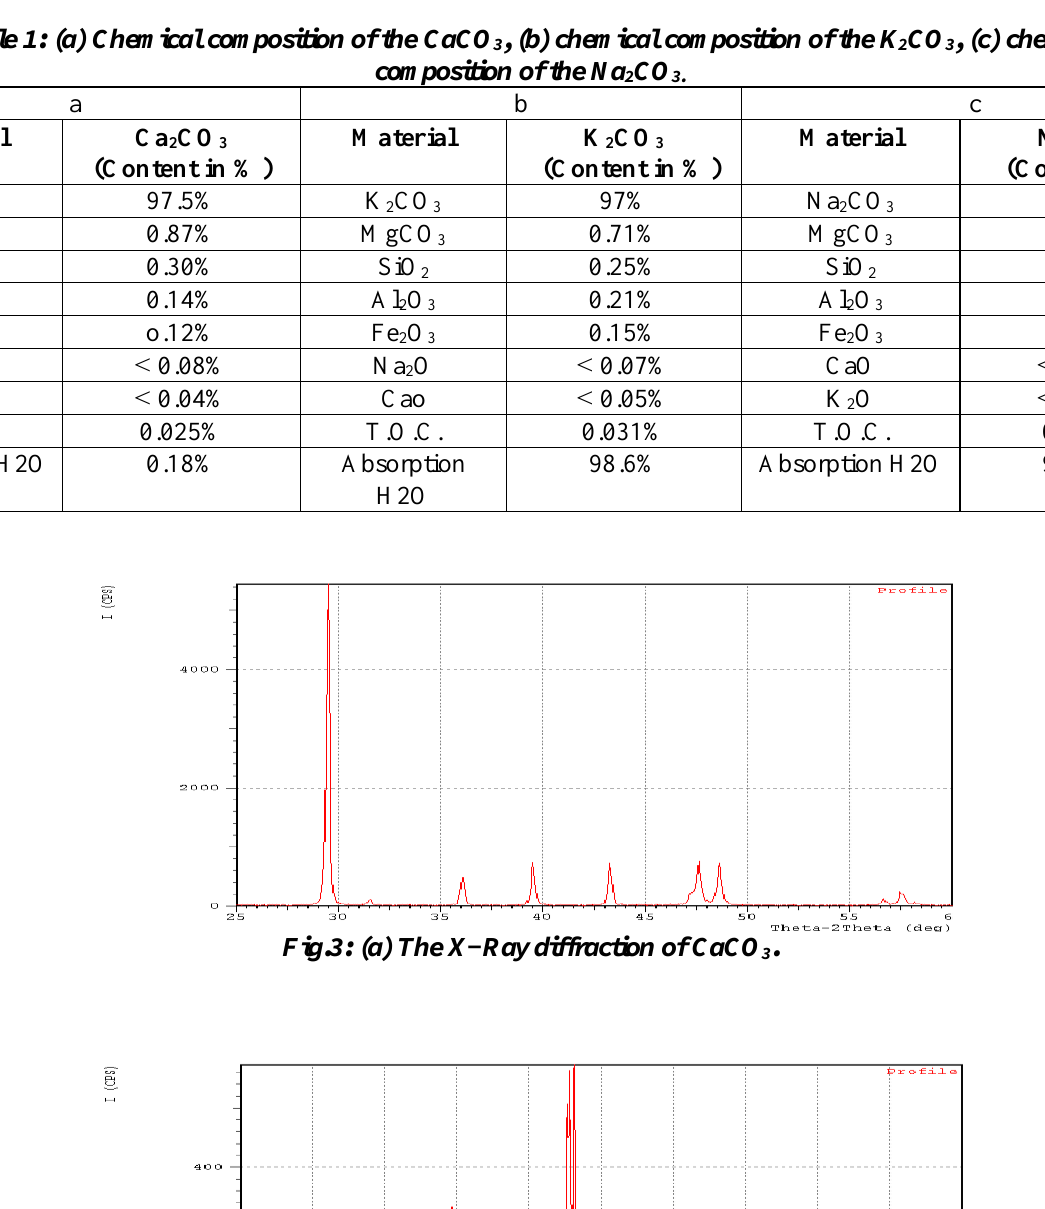
Table 1: (a) Chemical composition of the CaCO